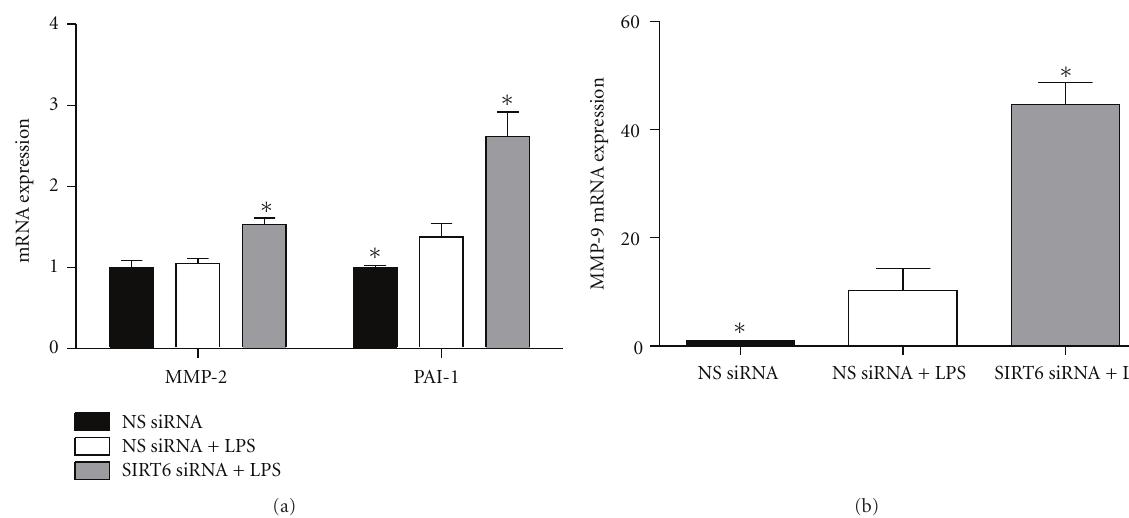
Figure 5: E ff ect of SIRT6 knockdown on ECM remodelling enzymes. HUVECs were transfected with 50nM SIRT6 or NS siRNA for 72 h followed by 10 μ g/mL LPS for 24 h ( n = 6). MMP-2, MMP-9 and PAI-1 mRNA expression was quantified by qRT-PCR. Each bar represents the mean ± SEM. ∗ P < 0 . 05 versus NS siRNA +